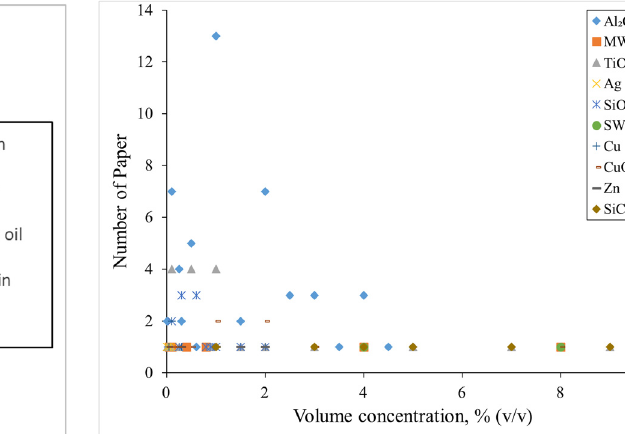
Figure 5: Distribution of nanoparticle concentration commonly used in MCHS